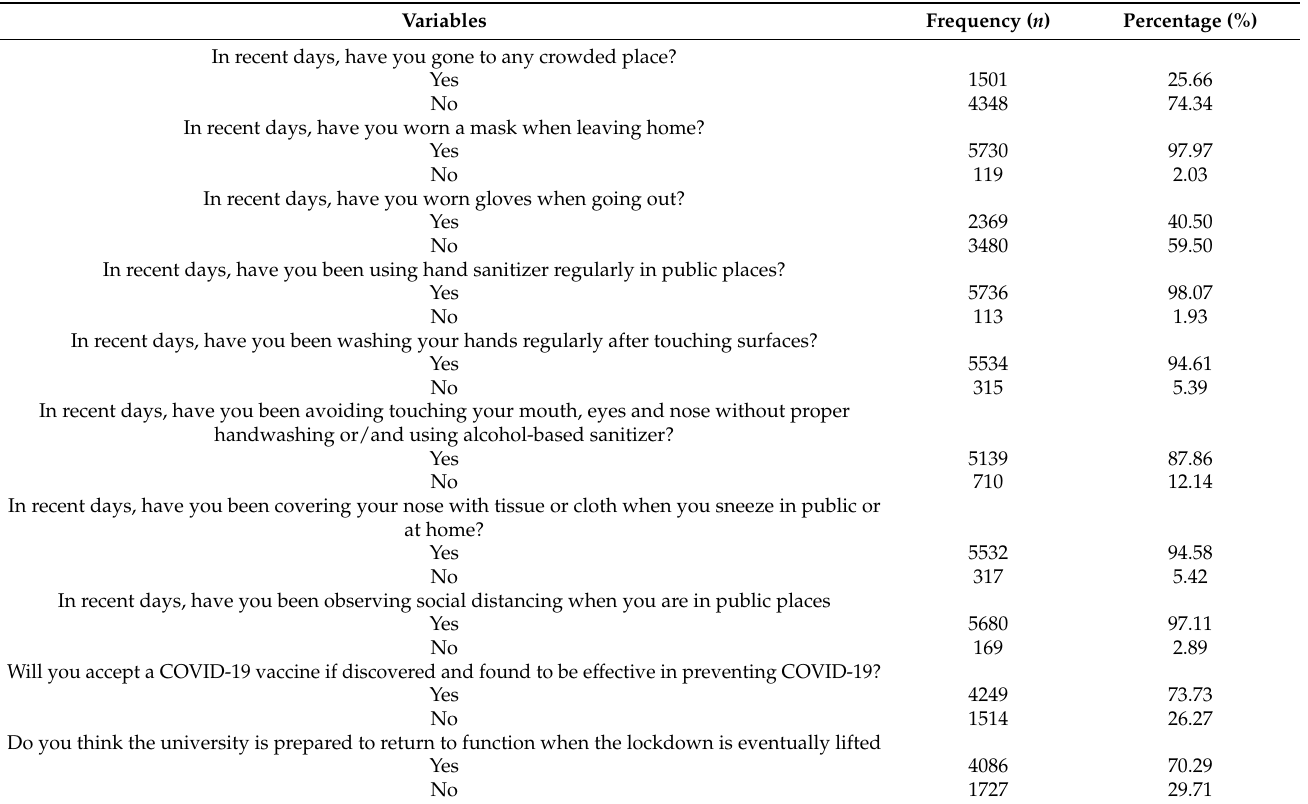
Table 3. Preventive practices towards COVID-19 transmission ( n =